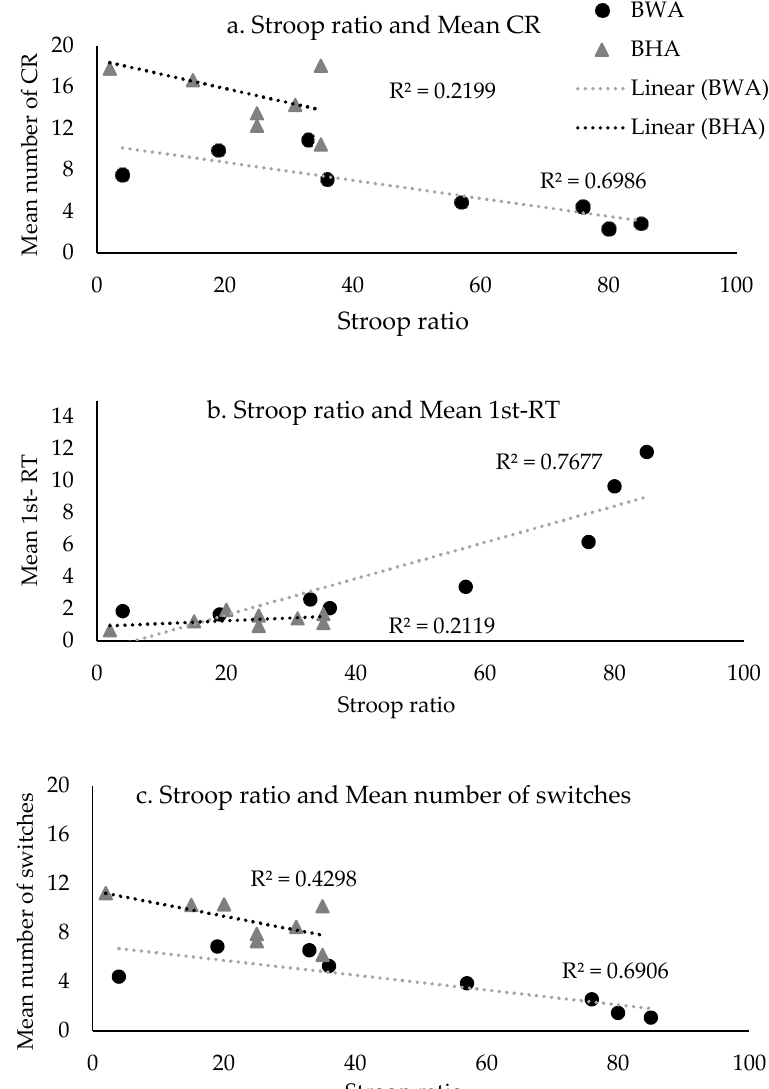
Figure 2. Correlation plots for the significant correlations between the Stroop ratio and verbal fluency parameters: ( a ) Mean number of CR, ( b ) mean 1st-RT, ( c ) mean number of switches for the two groups. BWA: Bilinguals with Aphasia: BHC: Bilingual Healthy Controls.